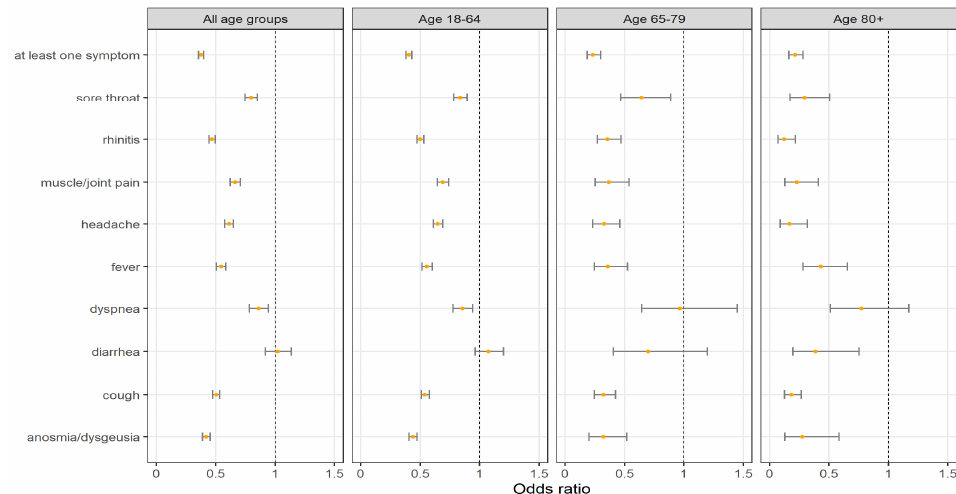
Figure 4. Symptoms in persons with a breakthrough infection and a prior COVID-19 infection ver- sus persons with a breakthrough infection without a prior COVID-19 infection. Logistic regression models adjusted for age, sex and vaccine brands, and stratified by age group, to assess the associa- tion of each type of symptom or of having ≥ 1 symptom (versus no symptom) with prior COVID-19 infection status. The error bars represent 95% confidence intervals. Persons with a breakthrough infection and having available data on symptoms were taken into account for this